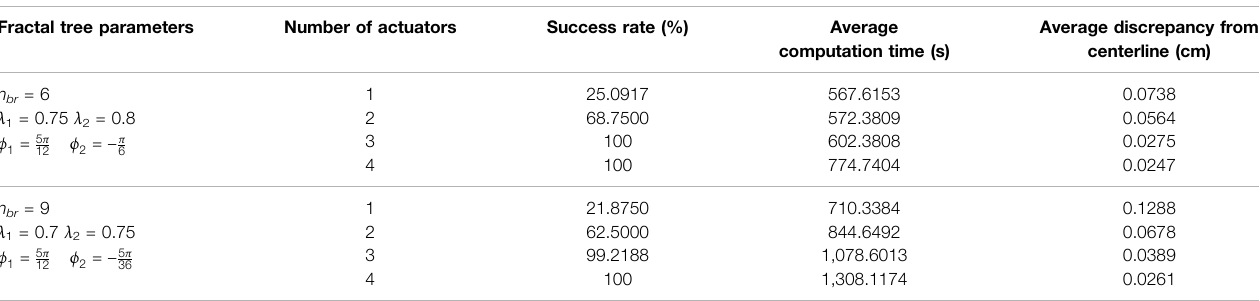
Average discrepancy from computation time (s) centerline (cm)